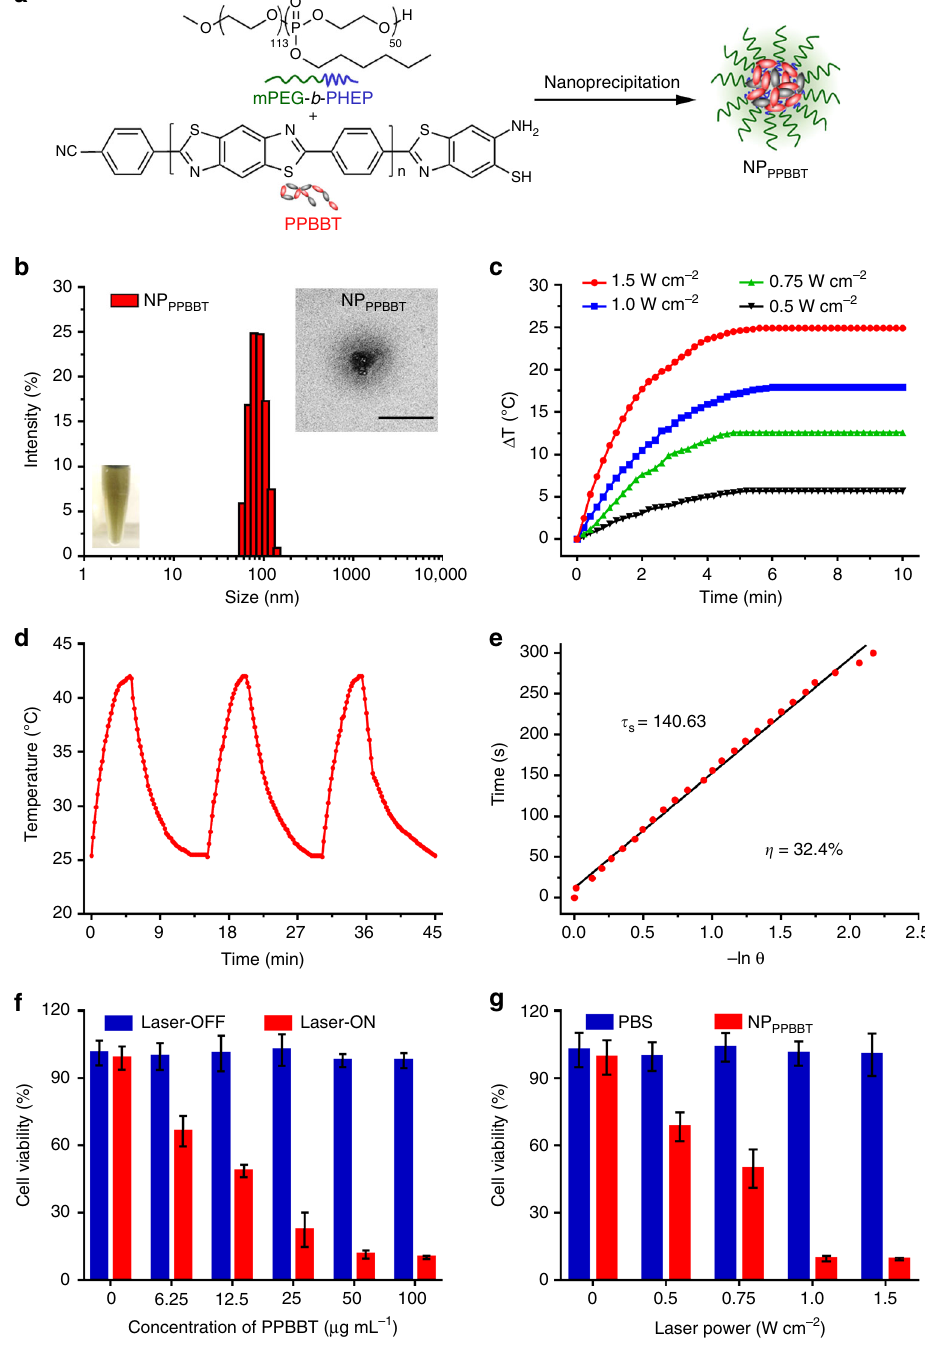
Fig. 3 In vitro photothermal properties and photo cytotoxicity of NP PPBBT . a Schematic illustration of the preparation of NP PPBBT . b DLS measurement of NP PPBBT . Insert: optical image (bottom left) and TEM image (top right) of NP PPBBT . Scale bar, 200 nm. c Time-dependent temperature change curves of NP PPBBT solution upon exposure to the 808 nm NIR laser at a power density of 0.5, 0.75, 1.0, or 1.5 W cm − 2 . d Temperature elevation curves of NP PPBBT over three cycles of 808 nm NIR laser on/off irradiation. e Linear correlation of the cooling times versus negative natural logarithm of driving force temperatures. f Relative photo (or dark) viabilities of EMT-6 cells after treatment with NP PPBBT at different concentrations with (or without) 808 nm NIR laser irradiation at 1.0 W cm − 2 for 10 min. g Relative photo viabilities of EMT-6 cells incubated with 50 μ g mL − 1 NP PPBBT (or PBS) under 808 nm NIR laser irradiation at different power densities. Results are presented as mean ± S.D., n = 4-chlorobenzenesulfonate salt (DiD), a NIR fl uorescent dye, was co- and the loading ef fi ciency of DiD was calculated to be 83% (Sup- encapsulated with PPBBT to form NP PPBBT /DiD nanoparticles to plementary Figure 21). Confocal laser scanning microscopy fl uor- study the cell uptake properity of NP PPBBT nanoparticles by EMT-6 escence images of the cells incubated with NP PPBBT /DiD for 0.25, 0.5, breast cancer cells. NP PPBBT /DiD nanoparticles were prepared using 1, 2, 4, or 8 h showed that the red DiD fl uorescence gradually the same nanoprecipitation method as that of NP PPBBT nanopartciles increased inside cells and approached its plateau at about 4 h 37